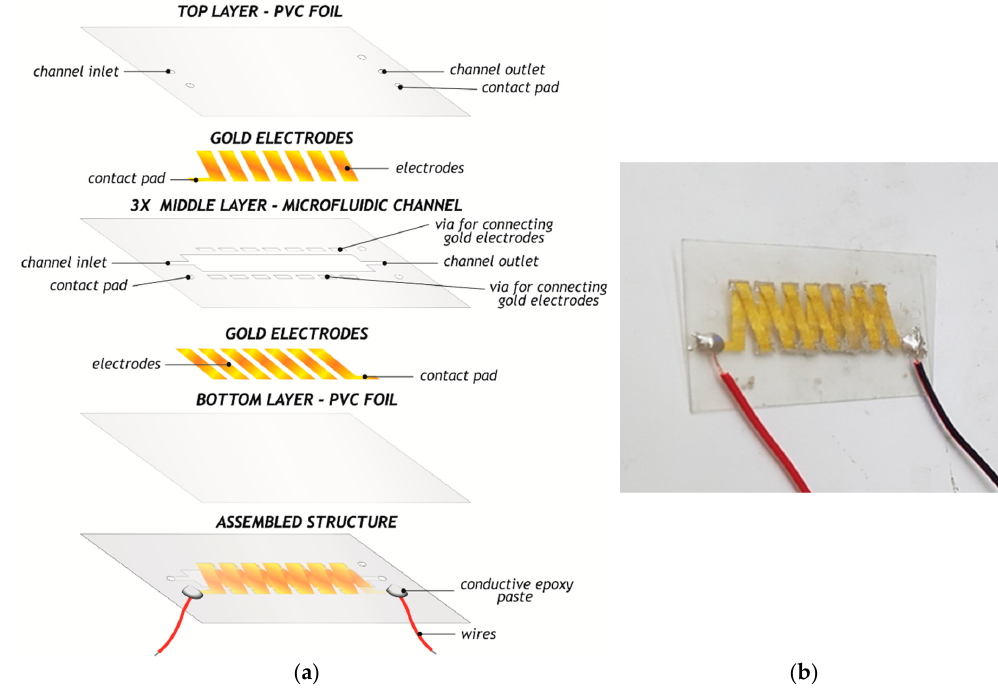
Figure 4. ( a ) Design of all layers of the inductive solenoid structure with microfluidic channel in the middle layers, ( b ) fabricated microfluidic solenoid inductor with two terminals.